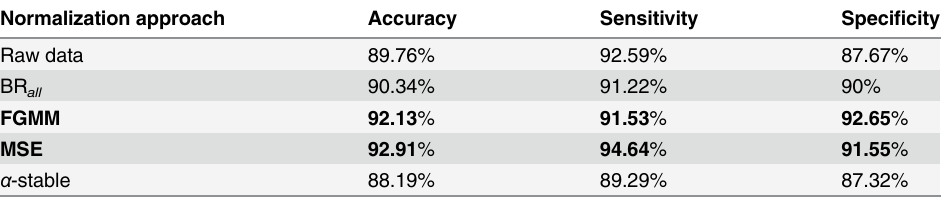
Table 4. Comparison between the accuracy rates achieved with the proposed intensity normalization methodologies based on PCA feature extraction method and linear SVM classifier. Normalization